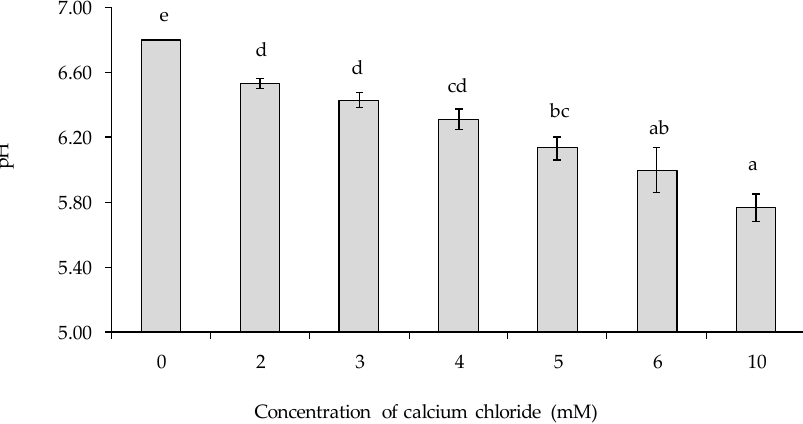
Figure 1. Influence of calcium chloride addition level, in the range 0–10 mM, on the pH of lentil protein-stabilised emulsions. (a–d) Samples not sharing a common letter differed significantly ( p < 0.05).